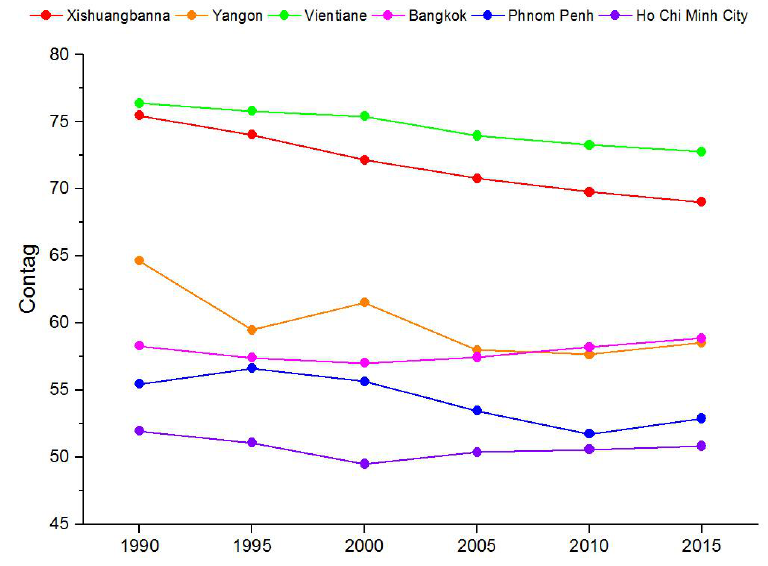
Figure 8. Variation of the CONTAG index in typical cities.